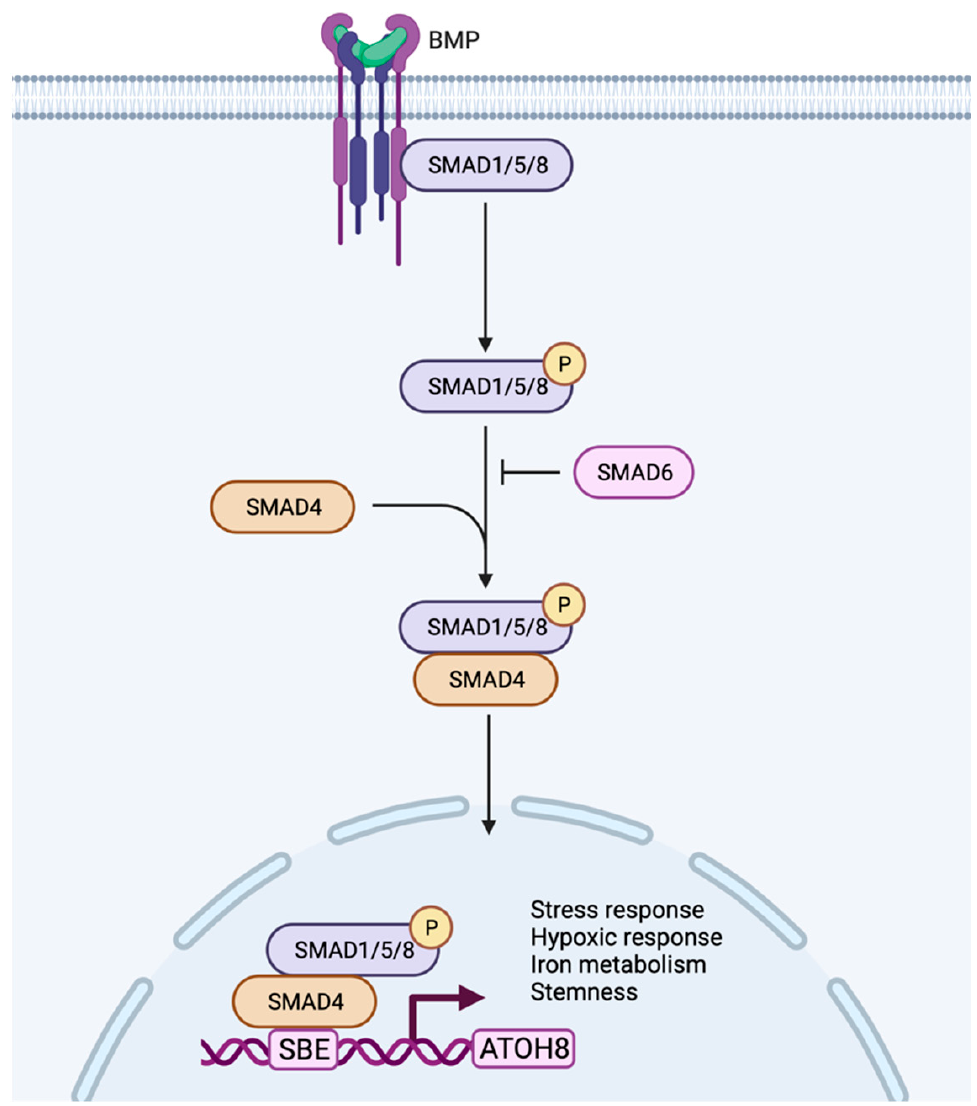
Figure 3. Working model of Atoh8 activation by canonical BMP signaling pathway. In the canonical pathway, BMPs transduce their signal by assembling type I or type II receptors to form a hetero- tetrameric complex. The assembly of receptors initiates transphosphorylation of type I receptors by type II receptors which further phosphorylates and activates R-Smads (Smad 1/5/8). The activated Smad1/5/8 interacts with Co-Smad (Smad4) to form a complex that further translocate into the nucleus to bind to the Smad Binding Element (SBE) of Atoh8 to initiate its transcription. Based on the current literature, the activated Atoh8 can be considered to regulate stress response, hypoxic re- sponse, iron metabolism and stemness of the cells.